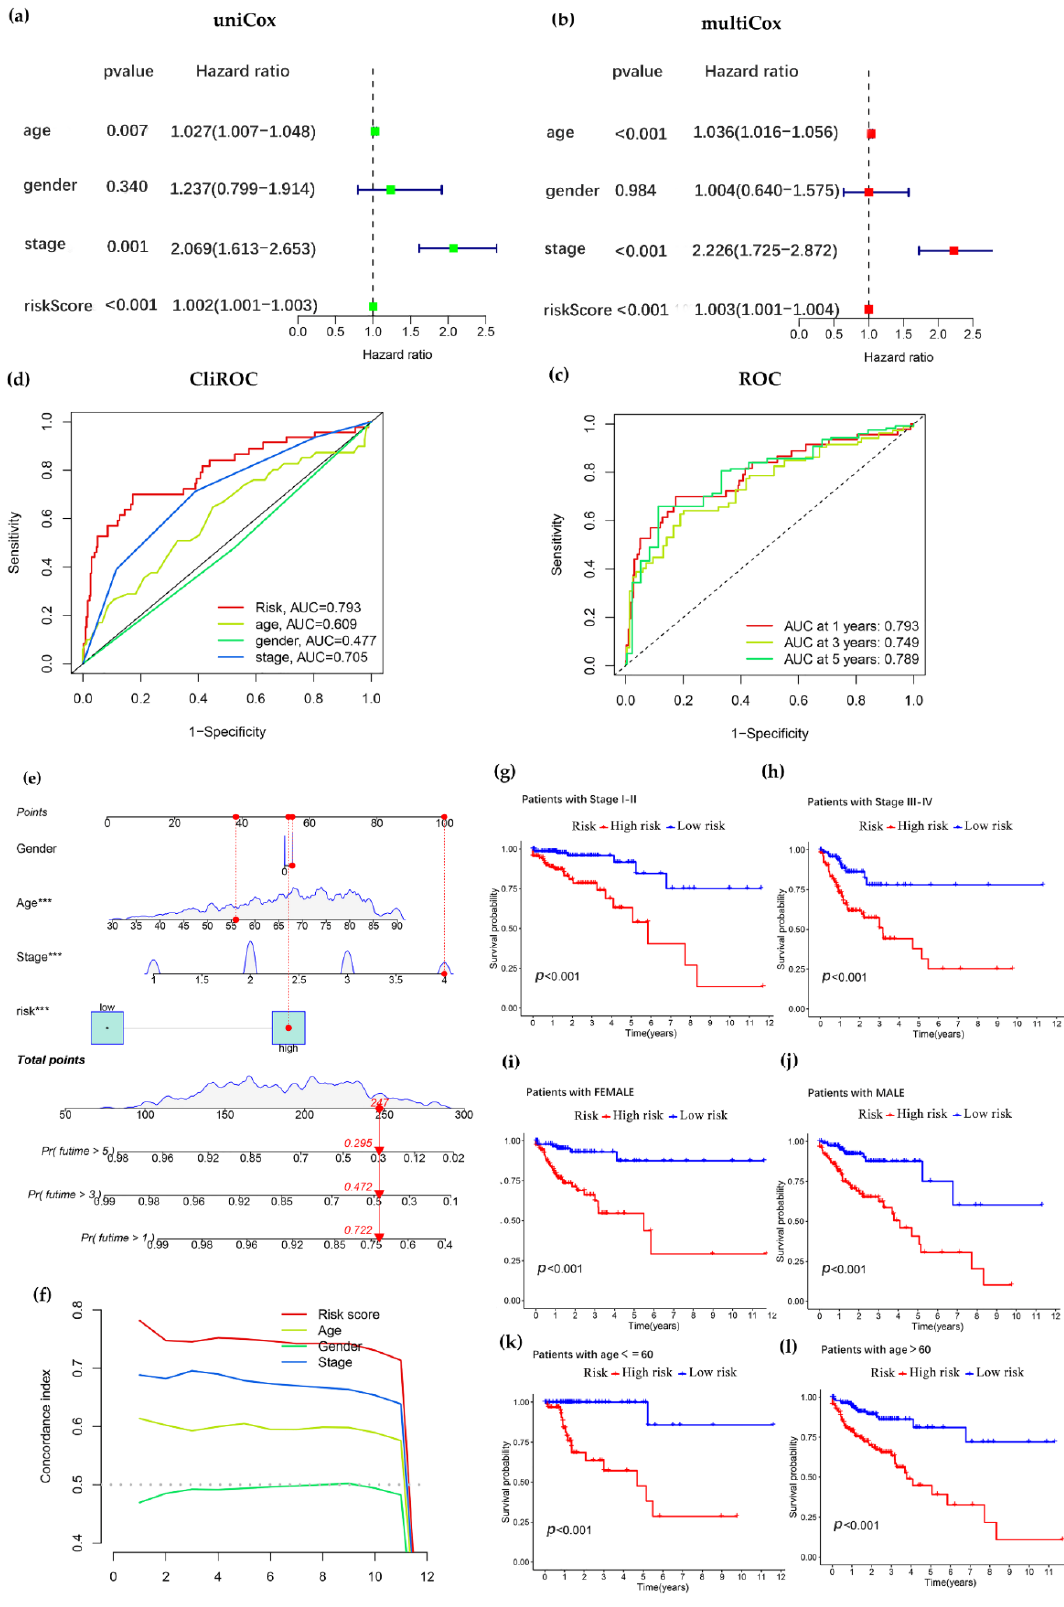
Figure 4. Validation of a prognostic model of cuproptosis-related lncRNA. ( a , b ) Univariate and mul- tivariate analysis of clinic pathological factors of overall survival in COAD patients. ( c )